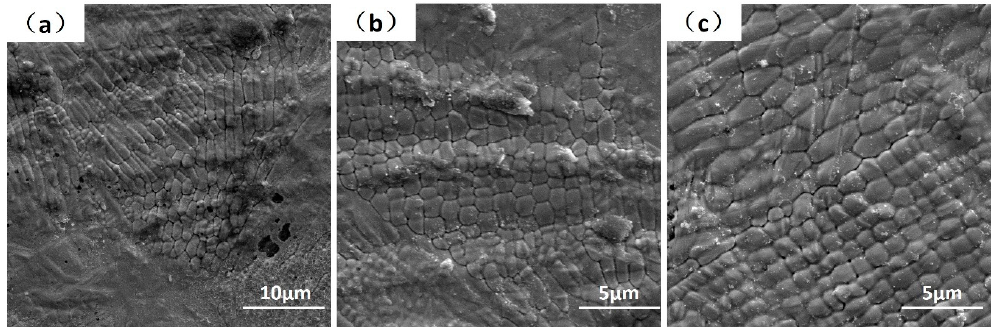
Figure 3. SEM images showing the geometric symmetrical cellular patterns in detail, demonstrating the mixed hexagon, pentagon and quadrilateral in the images ( a – c ), respectively.